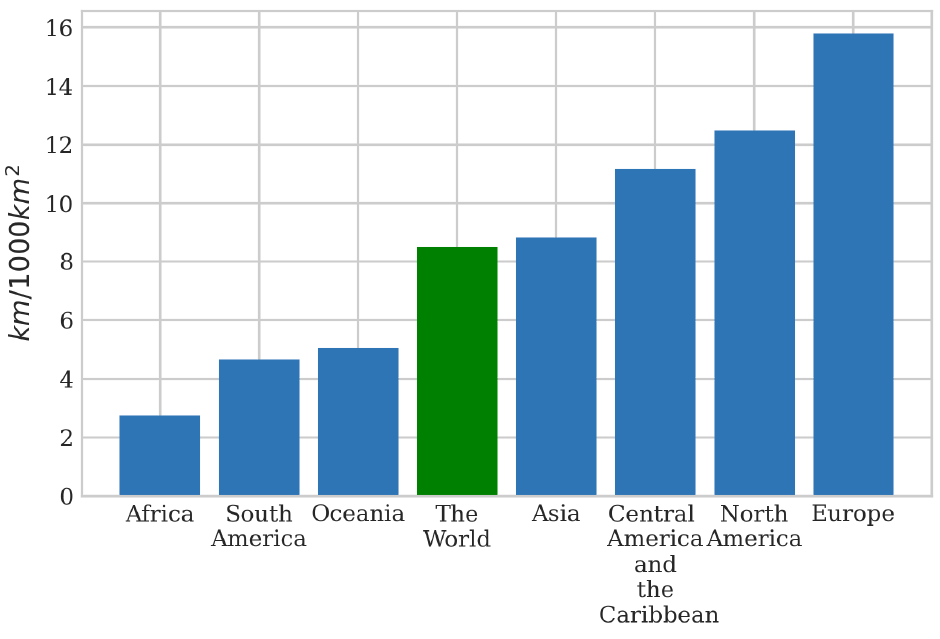
Figure 1. Density of railway network in km of railway lines per 1000 km 2 . Own study based on data from